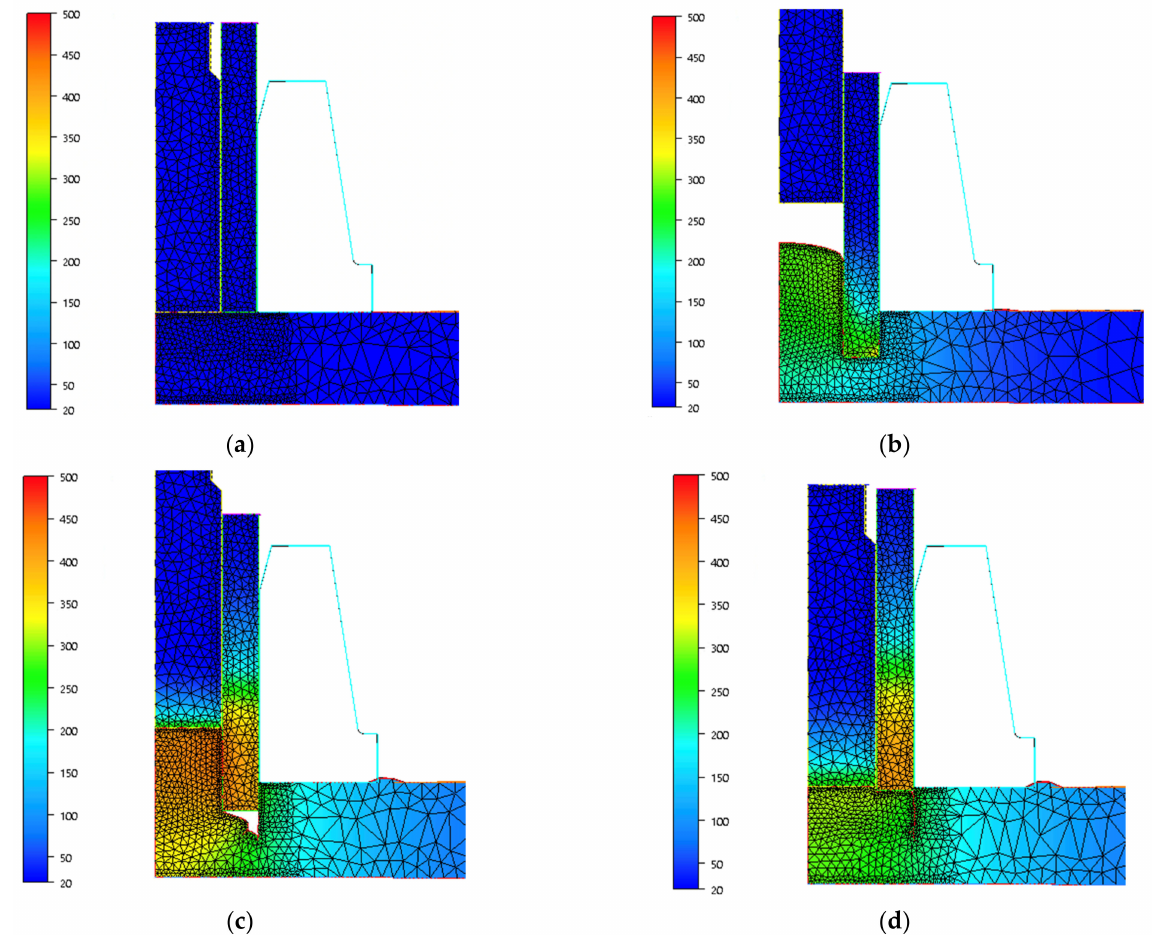
Figure 14. Visualization of the heat generation in the model: ( a ) initial position, ( b ) plunge stage at t = 0.5 s, ( c ) refill stage at t = 1.0 s, and ( d ) final